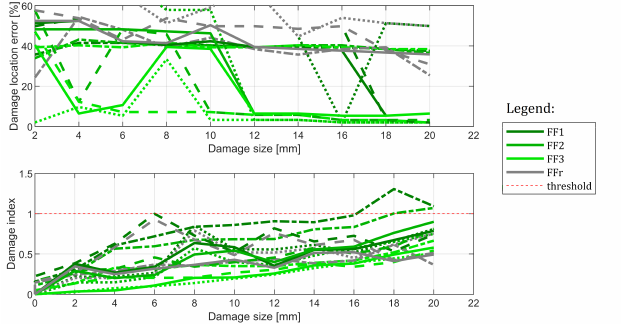
Figure 21. The results obtained for cases C#1, C#2, C#7 and C#8, that is for all the cases in which damage was located in the horizontal beam. The cases are denoted with dot-dash, dashed, solid and dotted lines,